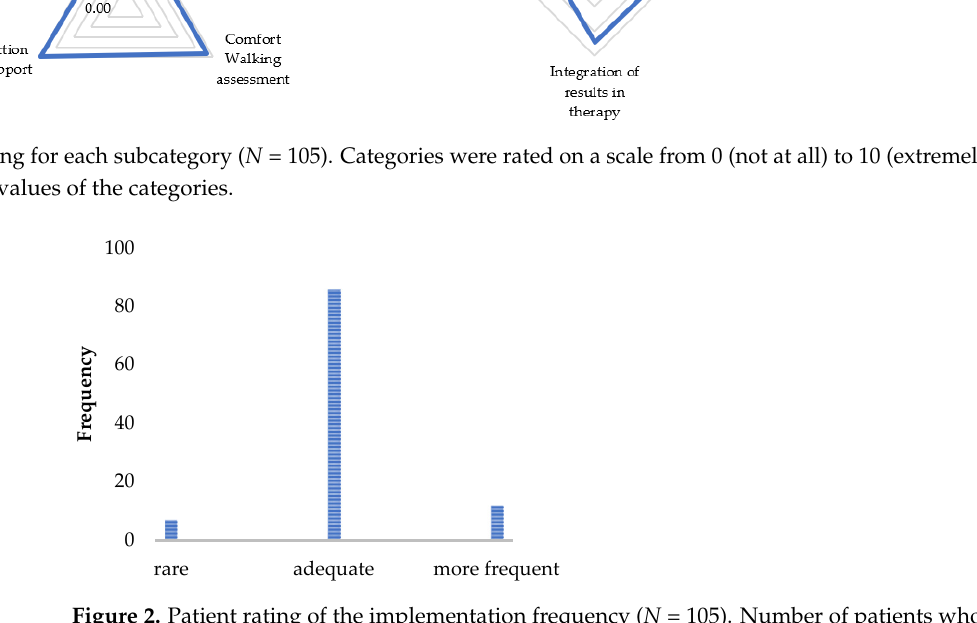
Figure 1. Patient rating for each subcategory ( N = 105). Categories were rated on a scale from 0 (not at all) to 10 (extremely). Presented are mean values of the